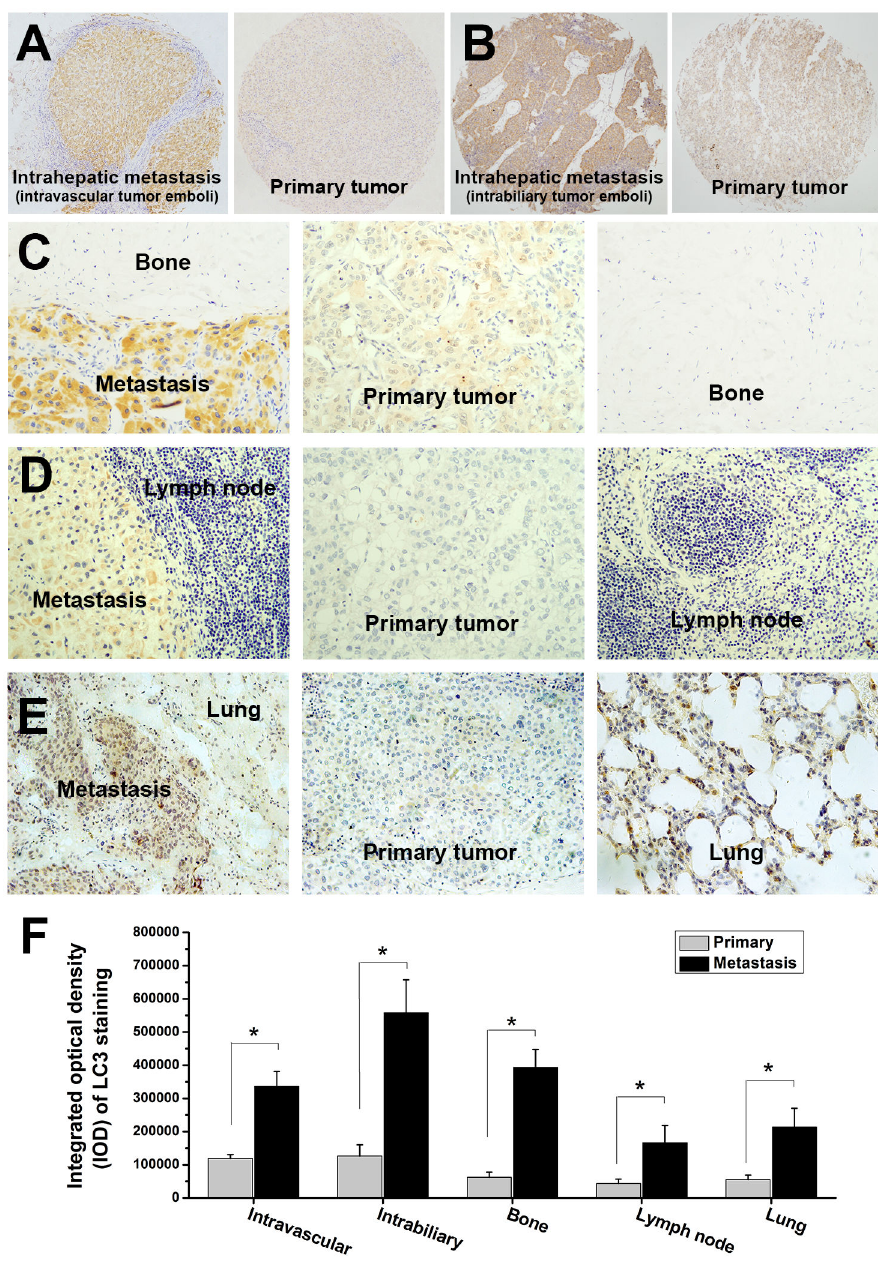
Figure 1. Immunohistochemical analysis of paired metastatic and primary tissues from HCC patients diagnosed with metastasis revealed significantly higher LC3 expressions in metastases than primary tumors. (A, B) TMA analysis of LC3 expressions in intravascular tumor emboli (A), intrabiliary tumor emboli (B) and paired primary tumors. (C, D, E) LC3 expressions in bone metastasis (C), lymphatic node metastasis (D), lung metastasis (E), paired primary tumors and normal tissues. (F) Integrated optical density (IOD) quantification of LC3 expressions in the metastases and primary tumors. doi: 10.1371/journal.pone.0074407.g001 significantly different from that in non-invaded cells too cell in migrated cells (11.3±2.1 at 12h) was not significantly (10.5±1.9 and 11.0±2.4 at 24h and 48h, all P >0.05) (Figure different from that in non-migrated cells (10.5±1.4 and 11.0±1.7 5C,D). at 6h and 12h, all P >0.05) (Figure 5B,D). The number of GFP- LC3 dots per cell in invaded cells (10.8±2.3 at 12h) was not